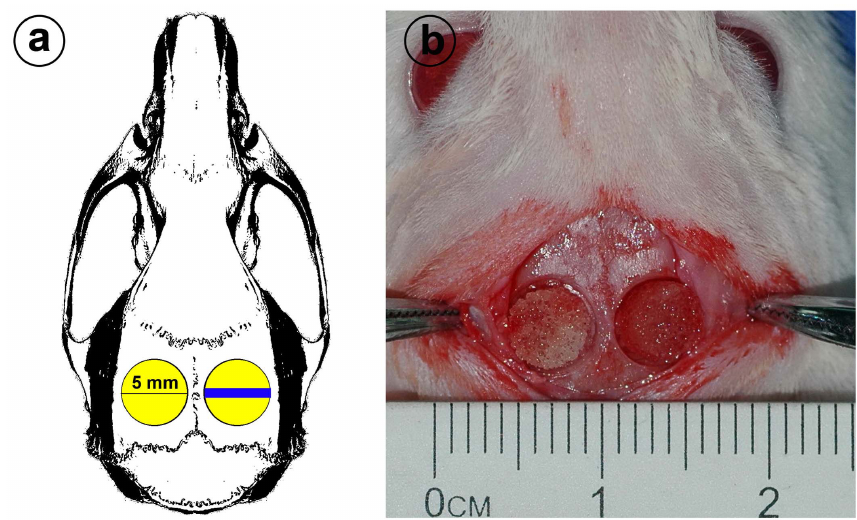
Figure 1. Animal model. (a) Schematic of rat cranial bone defects. Two 5 mm diameter critical size defects were made on the skull. The blue area shows the location where the tissue was taken for immunohistochemistry. (b) Rat cranial bone defects with silk scaffold-grafted.